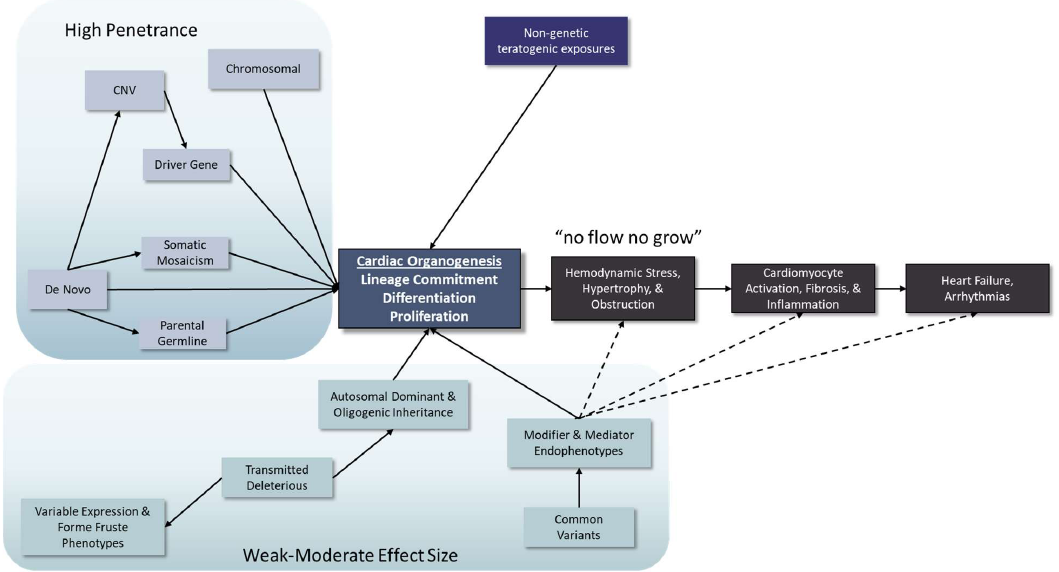
Figure 1. The known genetic causes of HLHS are complex. They include highly penetrant effects of pathogenic DNA variants where the presence of the genetic abnormality is determinative for the heart defect. There is also substantial evidence for weaker genetic influences in which both rare and common DNA variants contribute to increase the risk of the disorder. Cell differentiation, cell functional defects, and their associated anatomic abnormalities set the stage additional short- and long-term complications, which may also be influenced by genetic